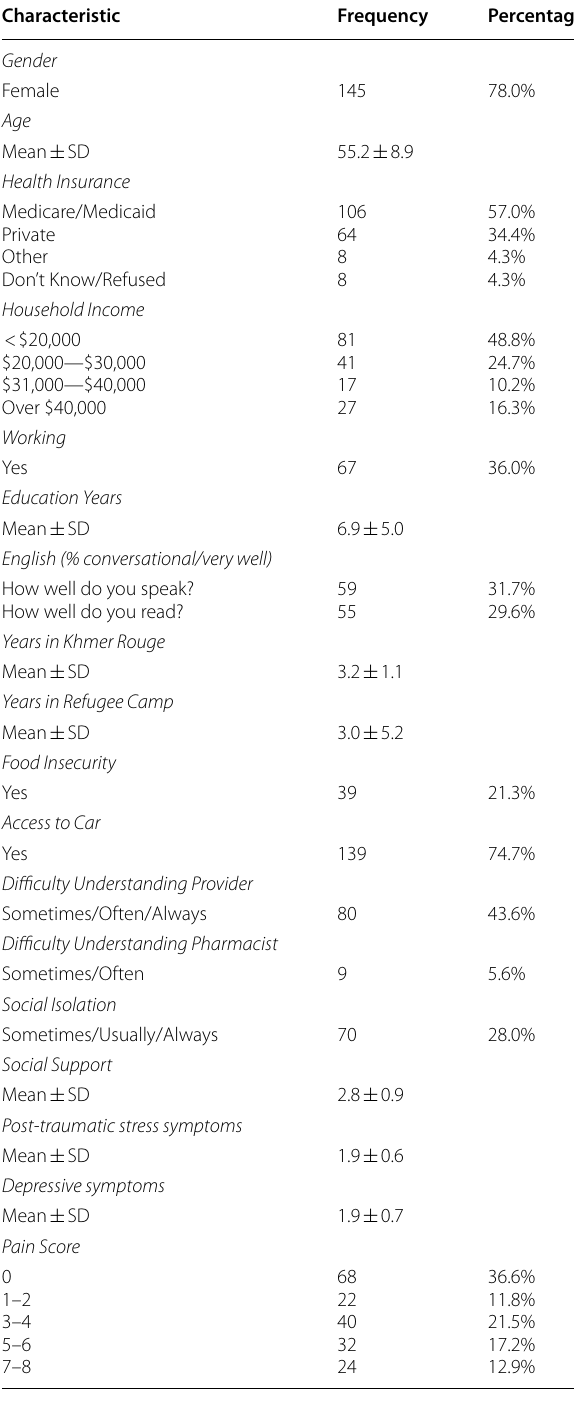
Table 1 Patient Characteristics ( n